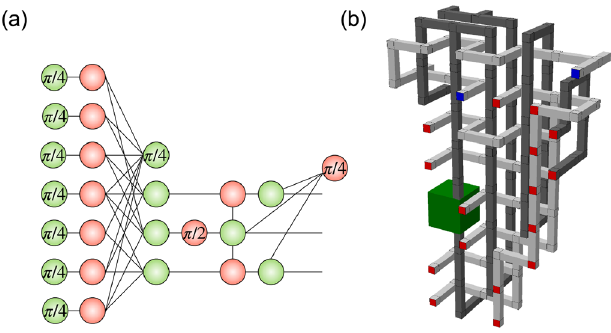
FIG. 9. (a) Reduced ZX-diagram for the j CCZ i -catalyzed 2 j T i factory from Ref. [52]. (b) Corresponding 3D structure after packing and applying the hybridized approach for braiding and defect-surgery discussed in Sec. VI. Here we follow Fig. 13 of Ref. [52] in substituting a green box for a single-qubit Clifford gate. We have marked the inputs of T states in red and the recycled T state for catalysis in